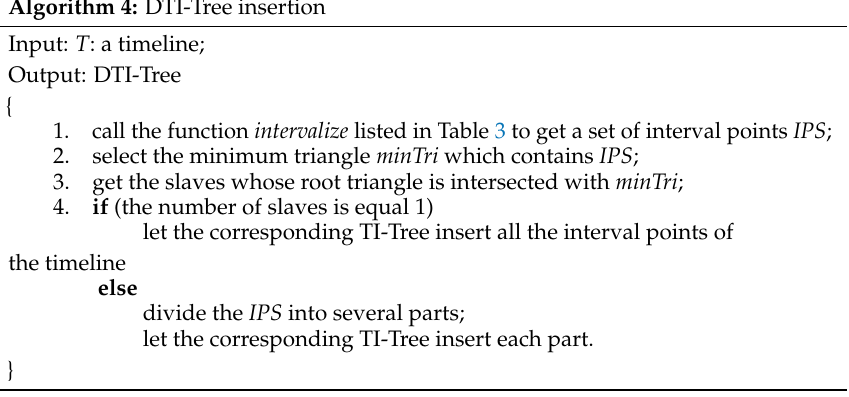
Algorithm 4: DTI-Tree